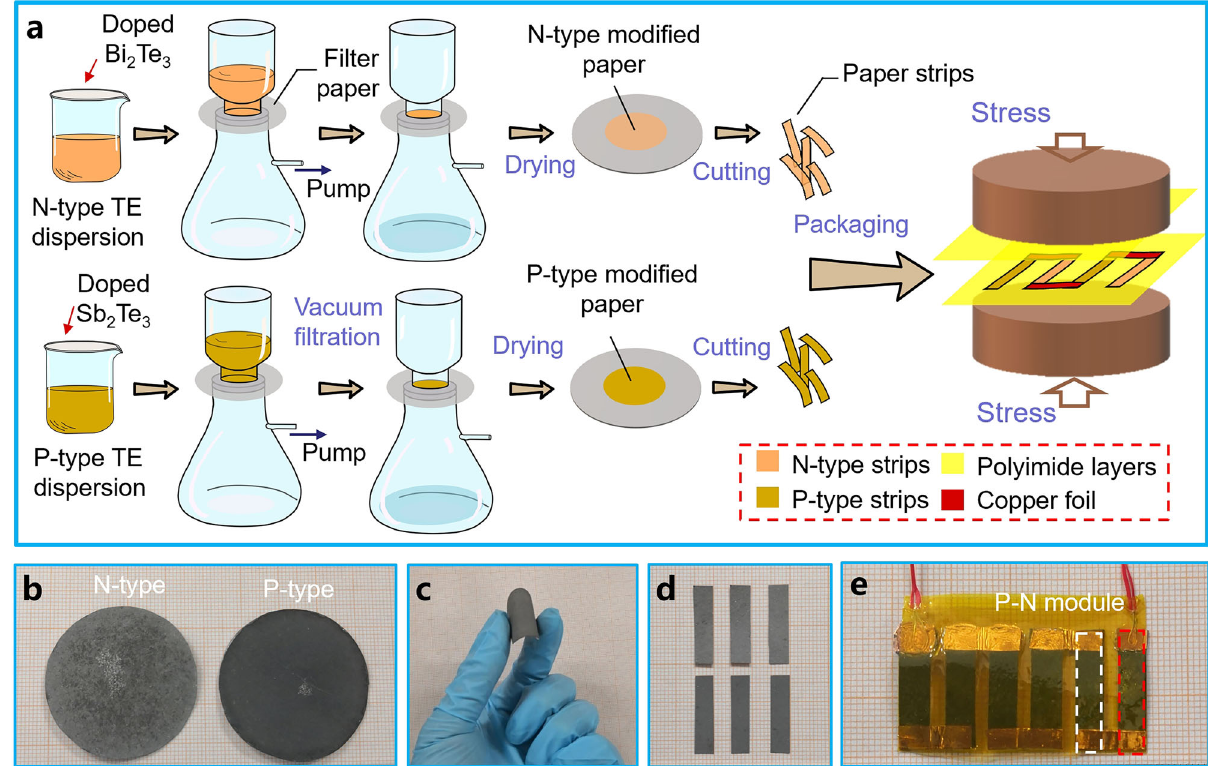
Fig. 1 Preparation process of fl exible paper-based thermoelectric generator (PTG) and the photos display. a Schematic diagram of the fabrication process for PTGs. The N- and P-type modi fi ed papers are prepared through the vacuum fi ltration method, cut into small strips and connected with copper foil in an alternating sequence. b – e Photographs of the complete modi fi ed papers obtained by the vacuum fi ltration method ( b ), displaying their high fl exibility ( c ), the small 5 mm × 20 mm strips ( d ), and the PTG with three units of P – N modules ( e ). The smallest grid point of the background grid paper represents 1